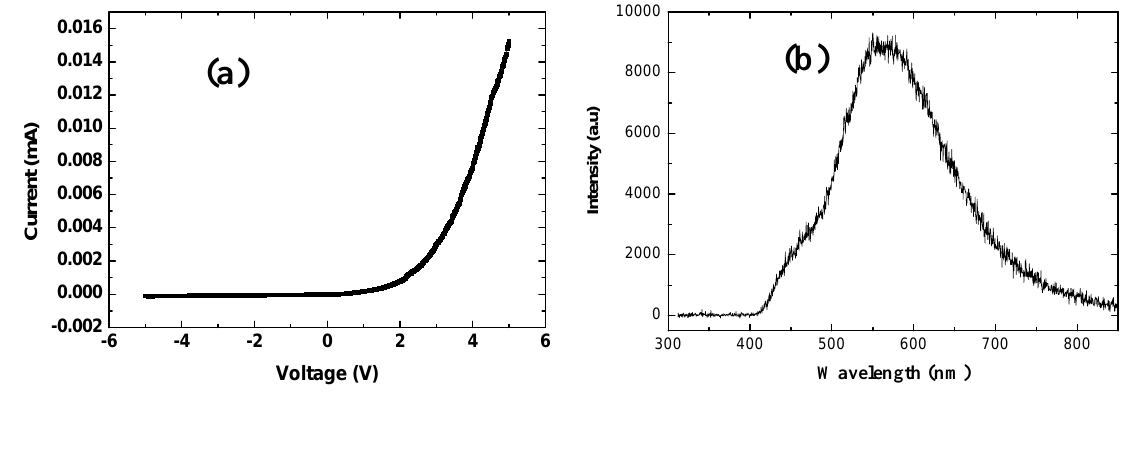
Figure 11. (a) I-V characteristics of the hybrid LED obtained using ZnO nanorods grown at 50 °C. (b) Electroluminence spectrum obtained from the hybrid LED revealing white luminescence covering the entire visible range (from above 400 nm and up to nearly 700 nm), resulting from the combination of the PFO/TFB and the low-temperature grown ZnO nanorods. The PFO emission at 450 nm appears in the EL as a